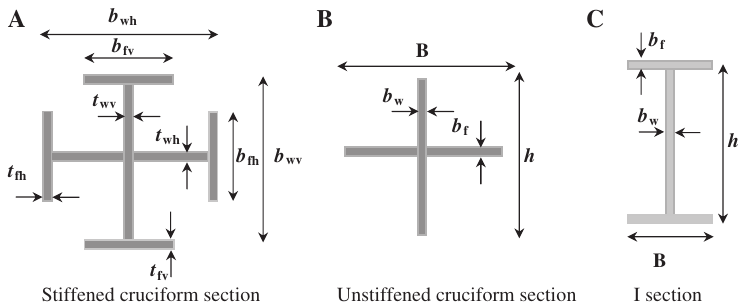
Figure 1 Geometry of thin-walled